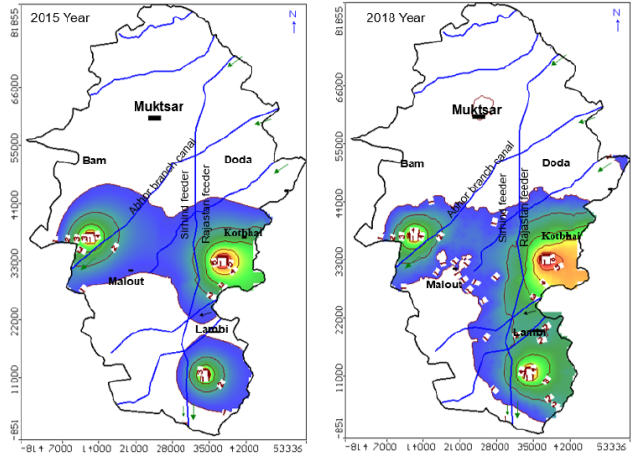
Figure 9. Groundwater level depletion at the end of 2015 and 2018 due to GEP with reference to 2011 water levels ( x ‐ and y ‐ axes are in m).